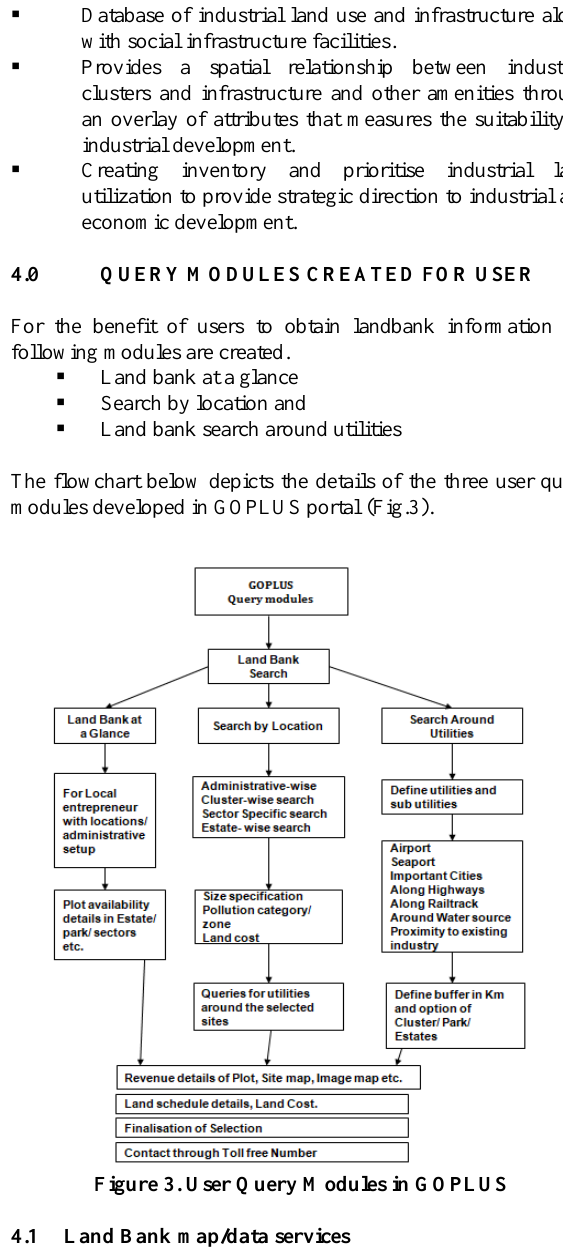
Figure 5. Land Bank Search Module to provide plot details, cost, pollution category